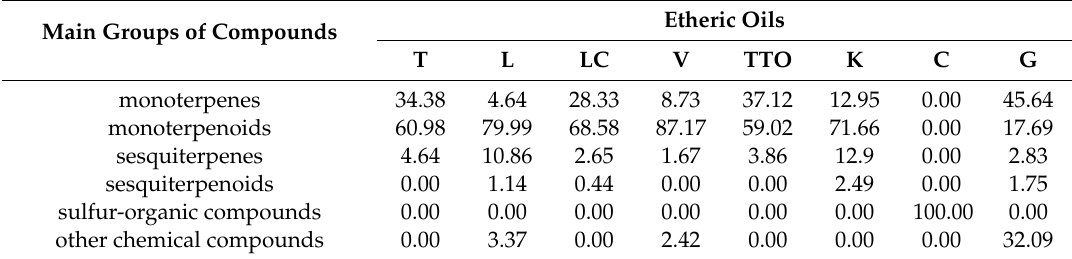
Table 3. Main chemical groups in thyme (T), lemongrass (L), Litsea cubeba (LC), verbena (V), tea tree (TTO), cajeput (K), garlic (C), grapefruit (G) oils.